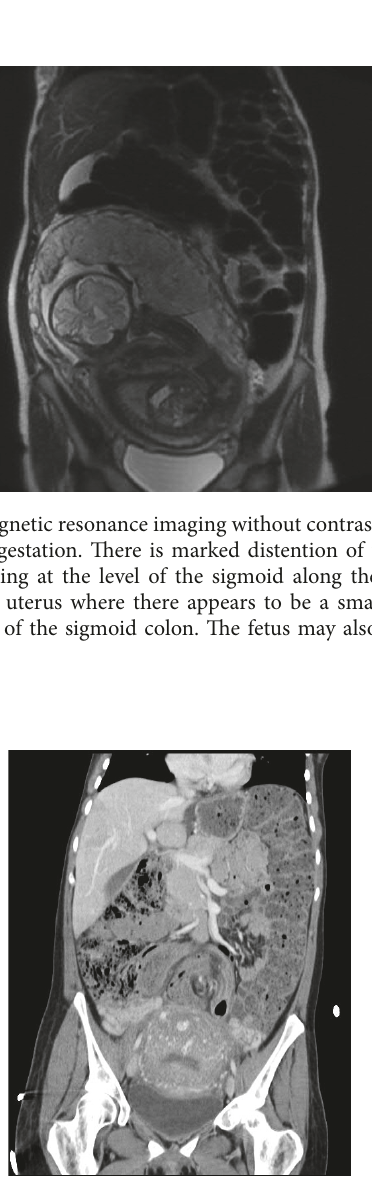
Figure 2: Computer tomography imaging with intravascular con- trast performed on postpartum day 1. There is twisting of the mesentery and focal mesenteric edema in the mid lower abdomen. The findings are consistent with sigmoid